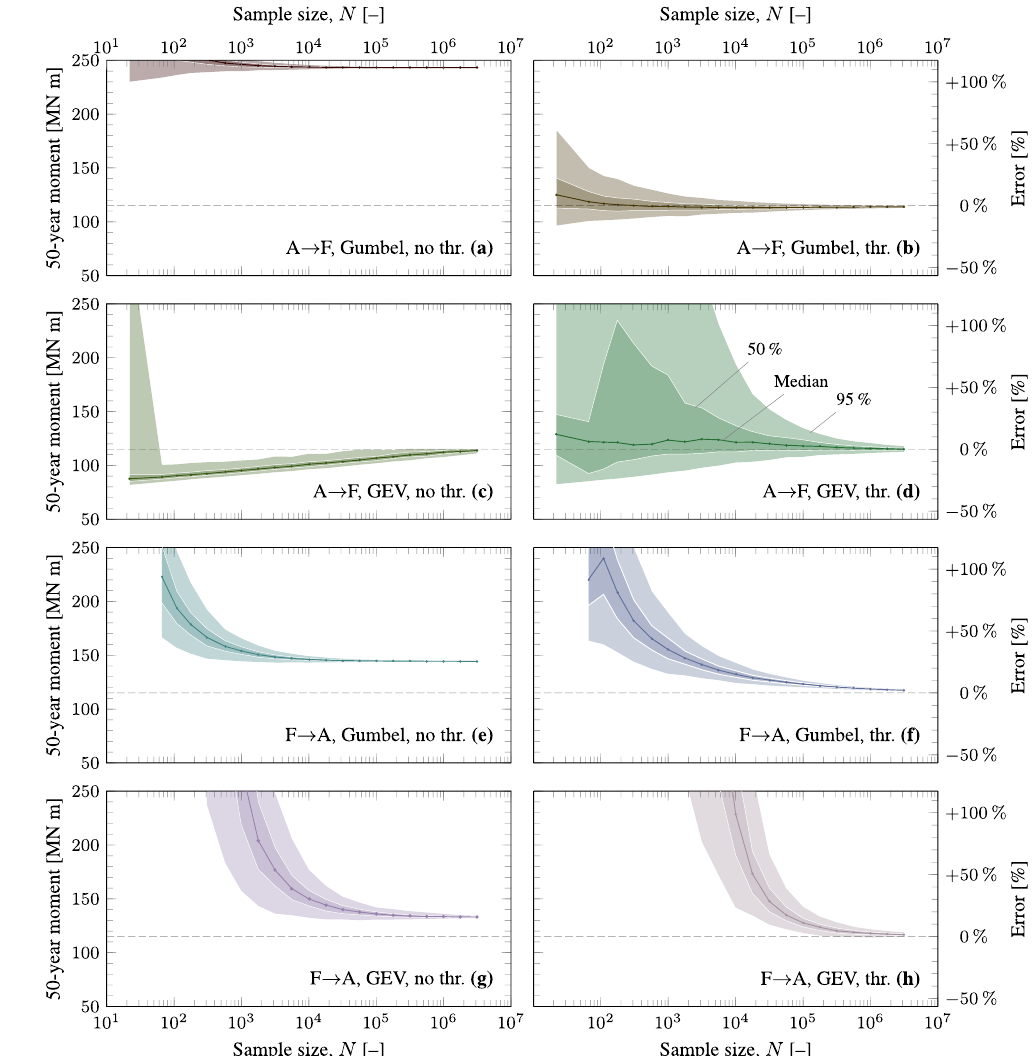
Figure 8. Error in the extrapolated 50-year overturning moment, as a function of sample